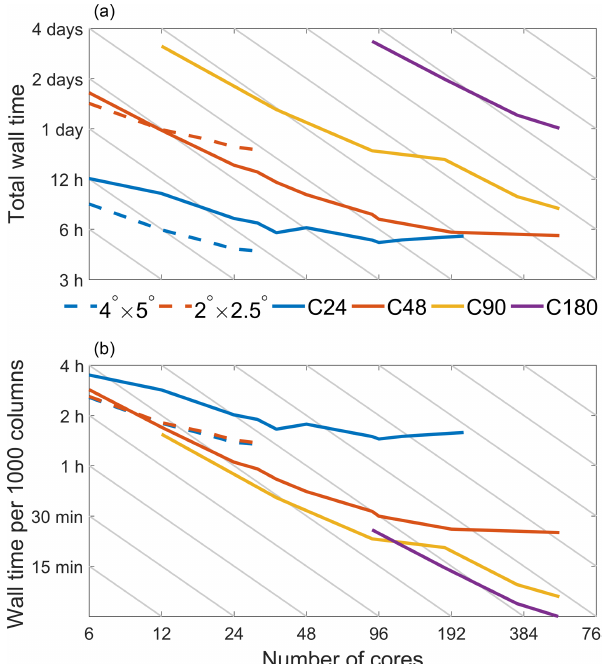
Figure 3. Wall time taken to perform 1-month GEOS-Chem simu- lations at different resolutions and with different numbers of cores. Panel (a) shows the absolute time taken to complete each simulation at each resolution. Panel (b) shows the wall time normalized by the number of atmospheric columns simulated at each resolution. Solid lines are for GCHP simulations (cubed-sphere grids) and dashed lines are for GCC simulations (latitude–longitude grids). Grey lines on each plot show perfect scaling, corresponding to a 50% reduc- tion in runtime for each doubling of the number of